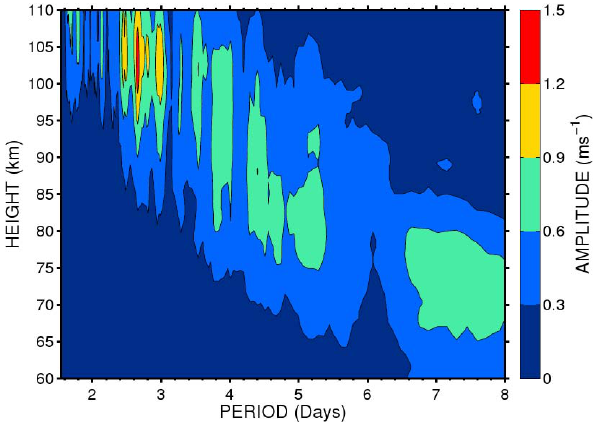
Fig. 3. Annually-averaged amplitude as a function of wave period vs. height of E1 waves in the zonal wind at 2.1 ◦ N in the Kyushu- GCM.